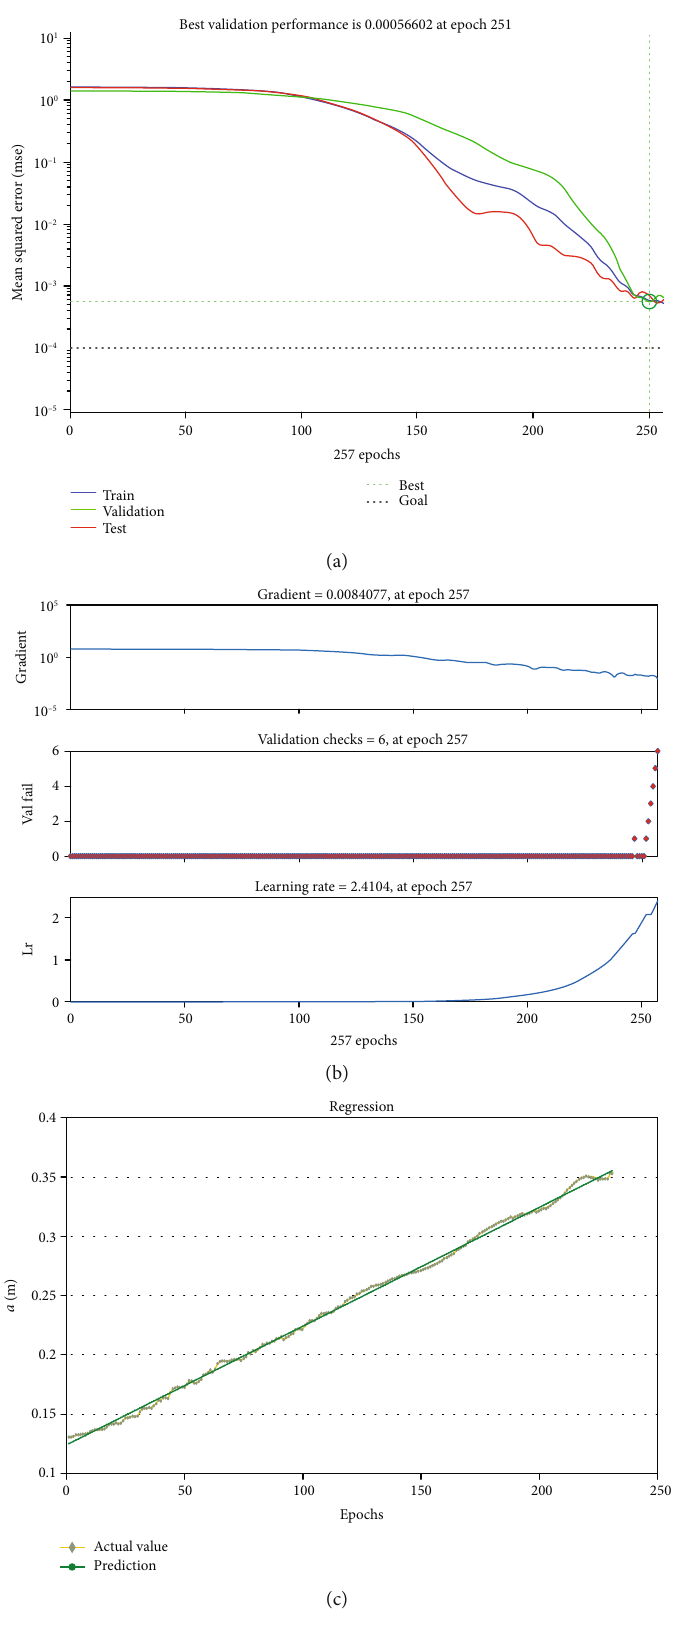
Figure 9: The results of the trained neural